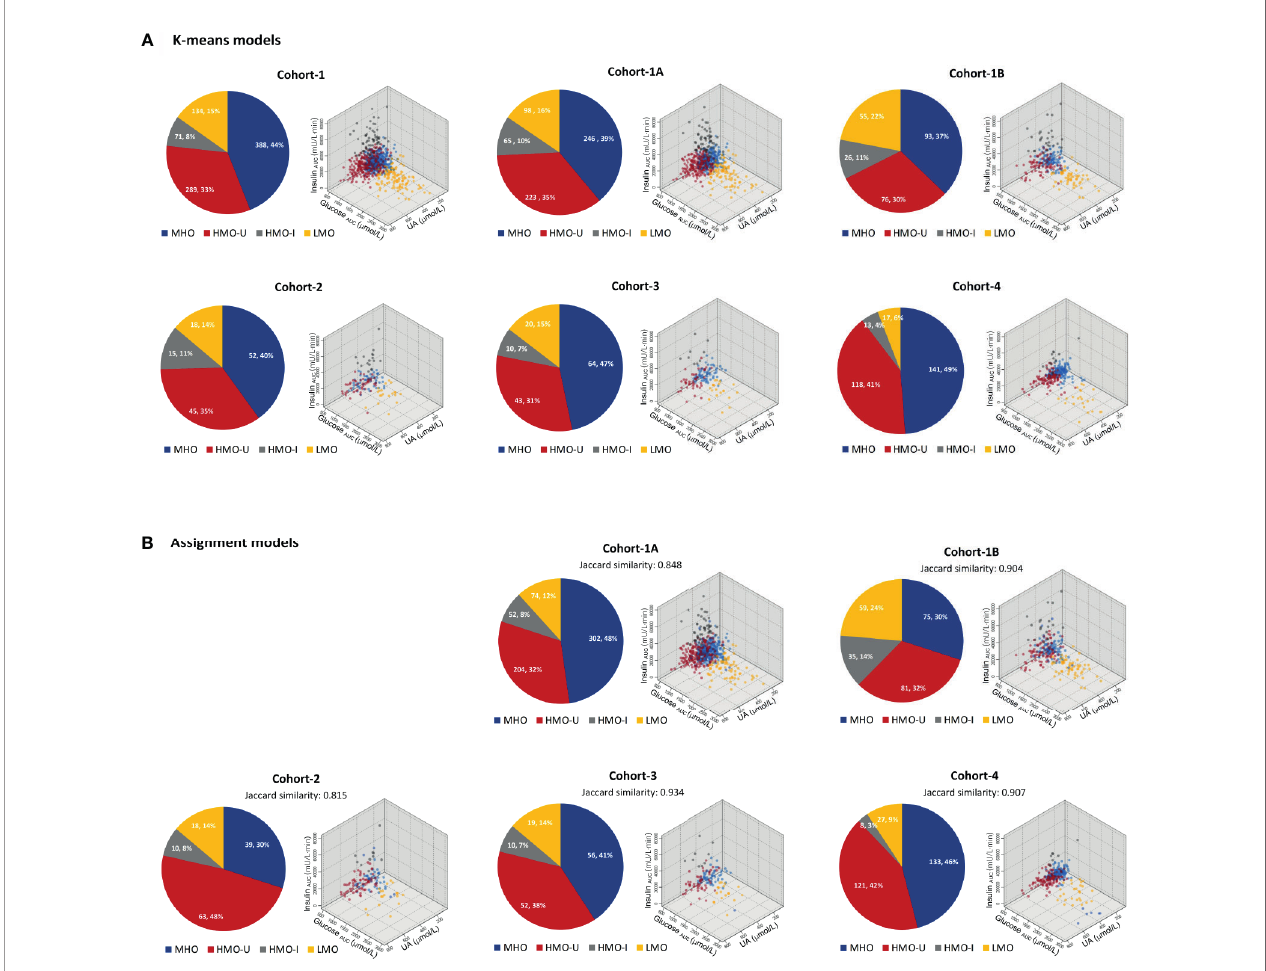
FIGURE 2 | Patient distributions and characteristics in each cohort with respect to the four clusters generated from machine learning. (A) Clusters generated independently from each individual cohort by using k-means. (B) Clusters generated by assigning patients in each veri fi cation cohort to the main model generated from Cohort-1. Data in the pie plots were shown as N (patient number) and its percentage over the full cohort. HMO-I, hypermetabolic obesity hyperinsulinemia subtype; HMO-U, hypermetabolic obesity hyperuricemia subtype; LMO, hypometabolic obesity; MHO, metabolic healthy